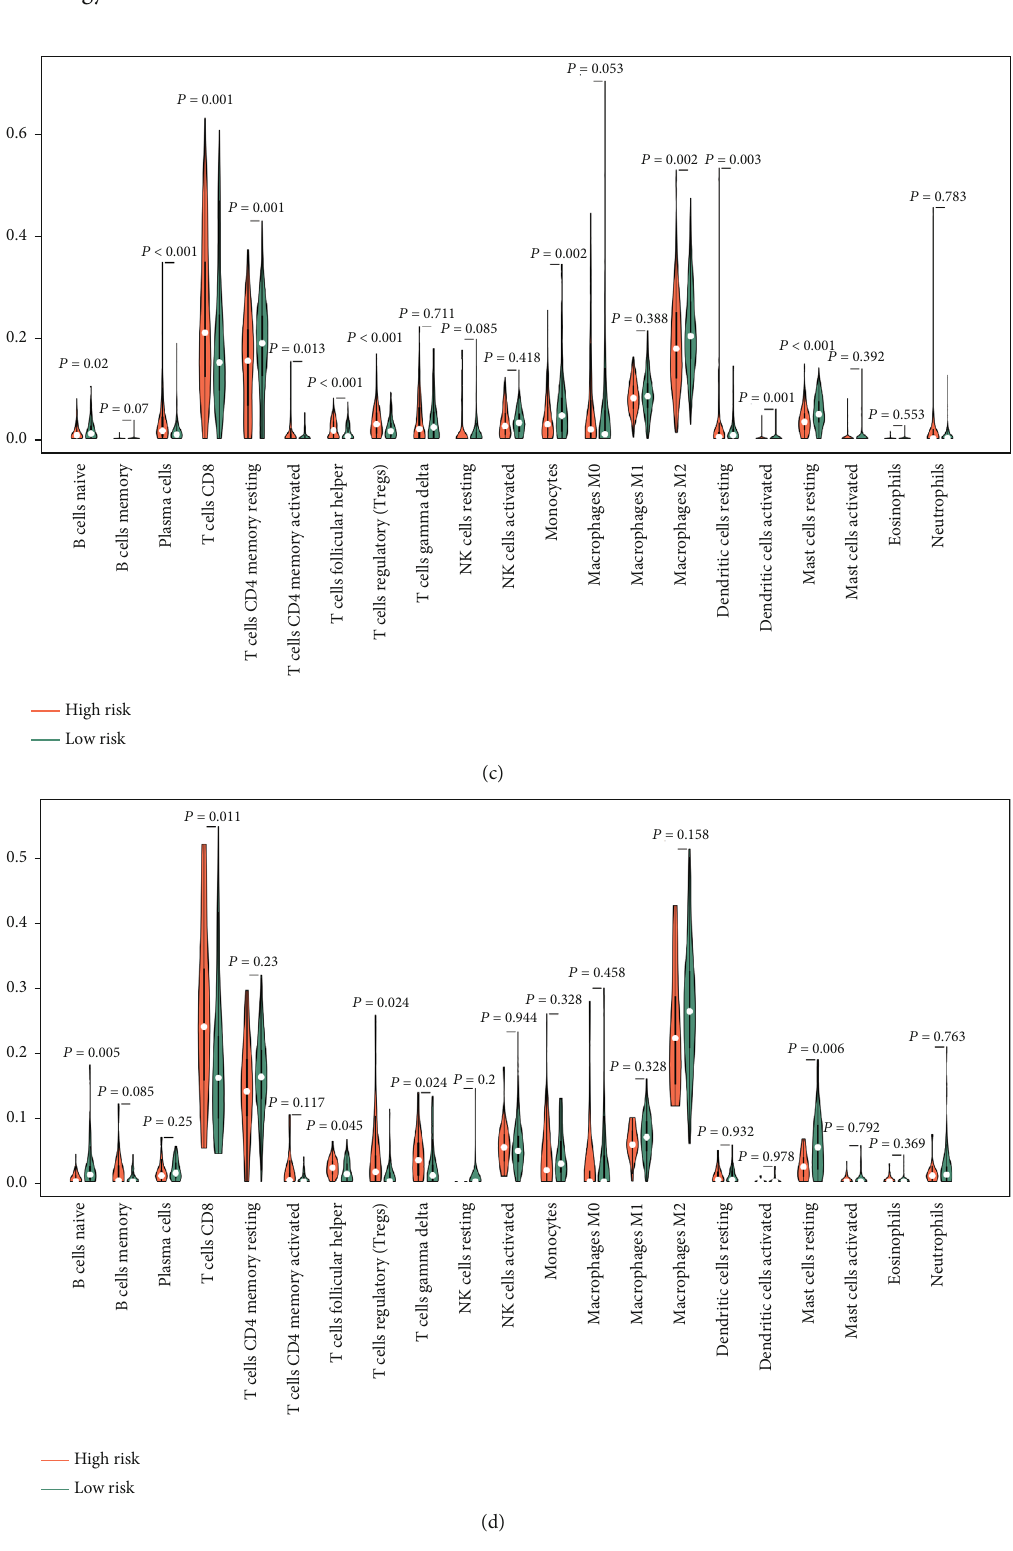
Figure 7: GSEA and the relation of the tumor-in fi ltrating immune cells to the fi ve-lncRNA signature. (a) Immune-related GO terms enriched in the high-risk group. (b) Associated KEGG terms enriched in the high-risk and low-risk groups. (c) Comparison of tumor-in fi ltrating immune cell proportion between the high-risk group and low-risk group in TCGA dataset. (d) Comparison of tumor-in fi ltrating immune cell proportion between the high-risk group and low-risk group in ICGC dataset. GSEA: Gene Set Enrichment Analysis; GO: Gene Ontology; KEGG: Kyoto Encyclopedia of Genes and